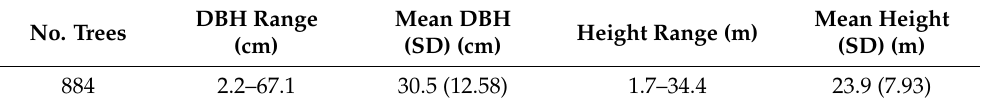
Table 1. Tree height and diameter distributions of the studied trees.